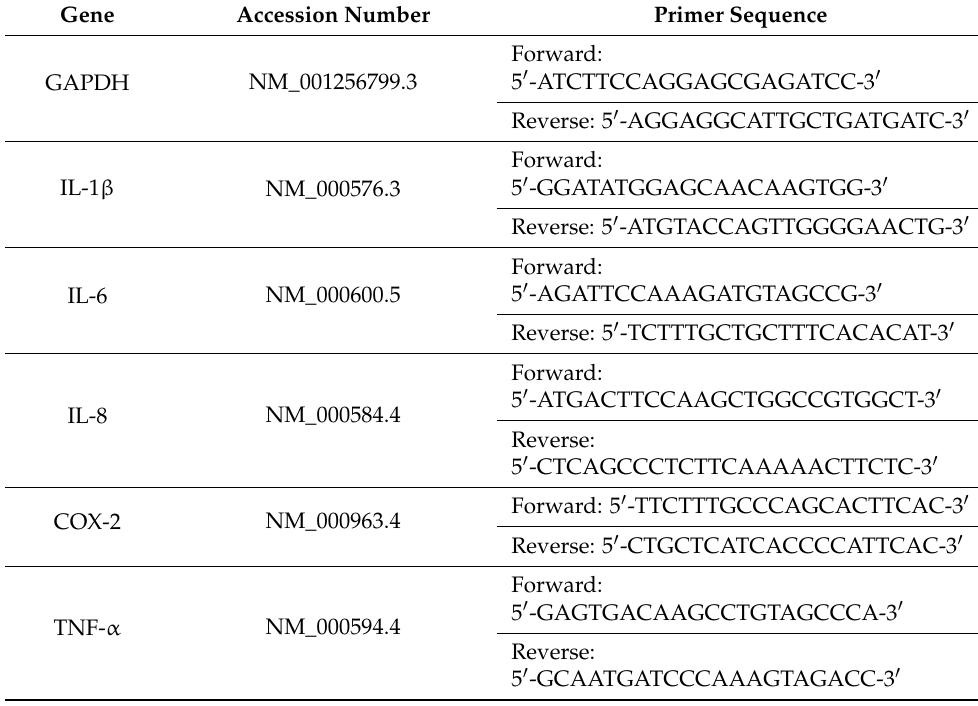
Table 1. The oligonucleotide primer sequences used for